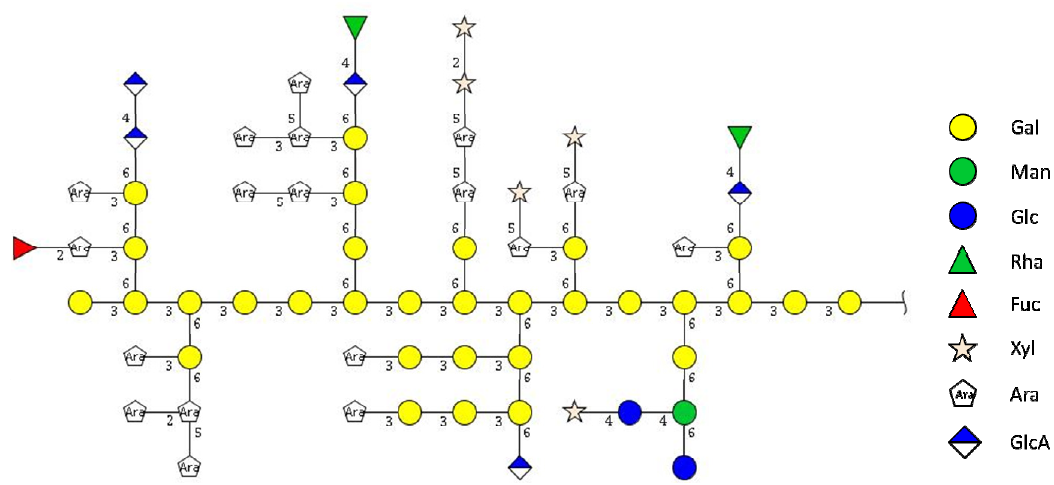
Figure 3. Proposed structure of the carbohydrate moiety of F2.